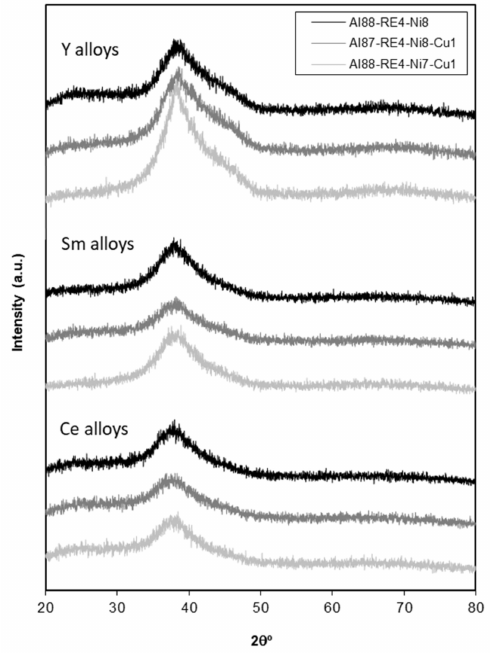
Figure 1. X-ray di ff raction (XRD) patterns of Al-RE-Ni-(Cu) melt-spun